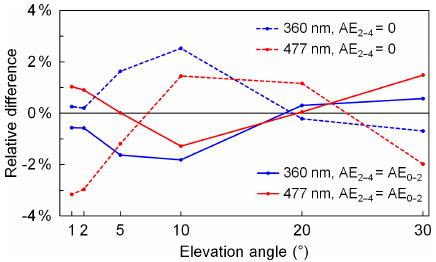
Figure B5. Relative differences of O 4 DSCDs at 360nm (blue lines) and 477nm (red lines) simulated with aerosol profiles with AE 2–4 (aerosol extinction coefficient between 2 and 4km above in- strument) equals to 0% (dashed lines) and 100% (solid lines) of AE 0–2 (aerosol extinction coefficient between 0 and 2km above instrument) comparing to the O 4 DSCDs simulated with a profile with AE 2–4 = 50%AE 0–2 . For all profiles, AE 0–2 = 0 . 04km − 1 . The other simulation parameters followed the settings listed in Ta- ble